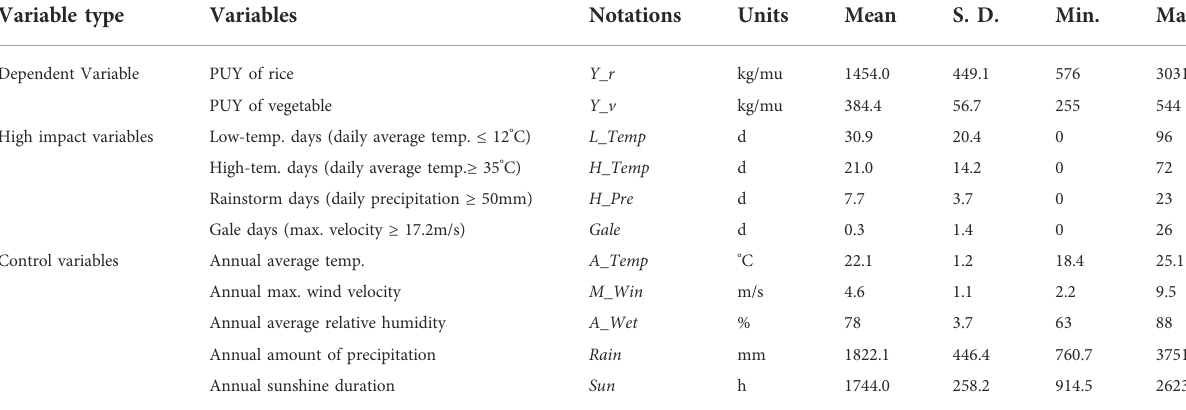
TABLE 1 The statistical description of the variables.